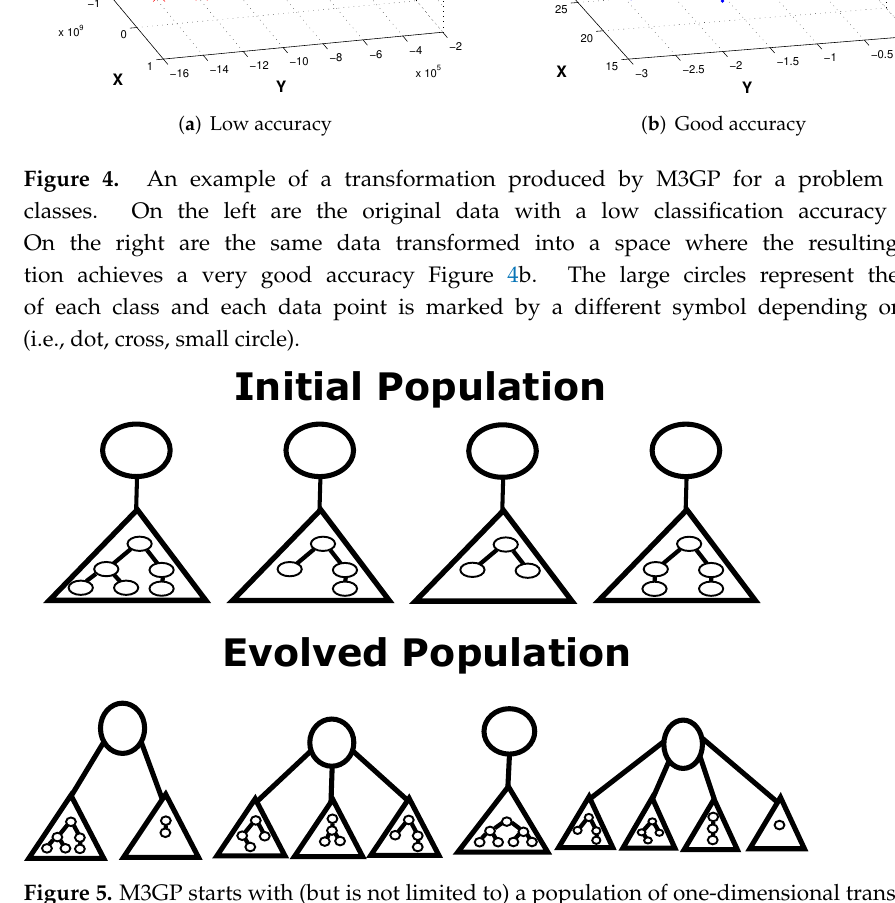
Figure 5. M3GP starts with (but is not limited to) a population of one-dimensional transformations. Through mutation (Figure 6b,c), the search can evolve into a multi-dimensional